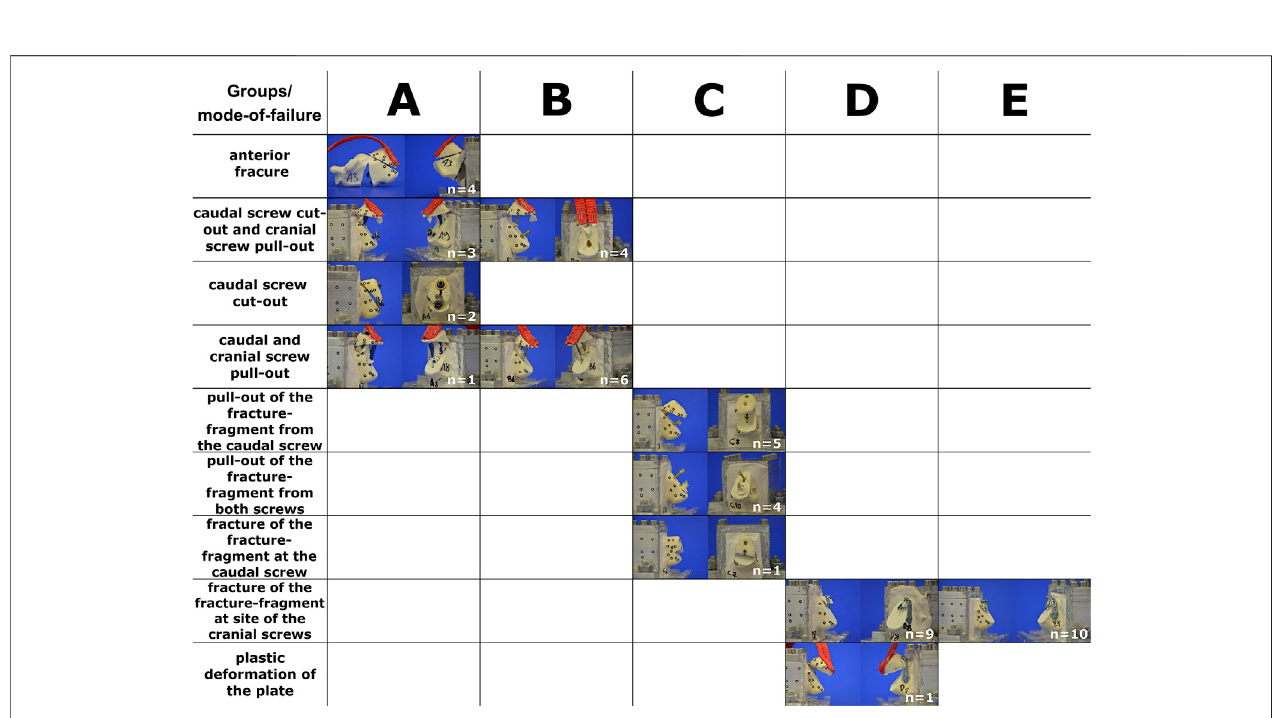
FIGURE6| Type ofimplantfailuresortedbygroups.Thehorizontalcolumn represents thegroups tested (A – E) .Theverticalcolumn describesthedifferentmodes of failure. Please see also Supplementary Material at the end.